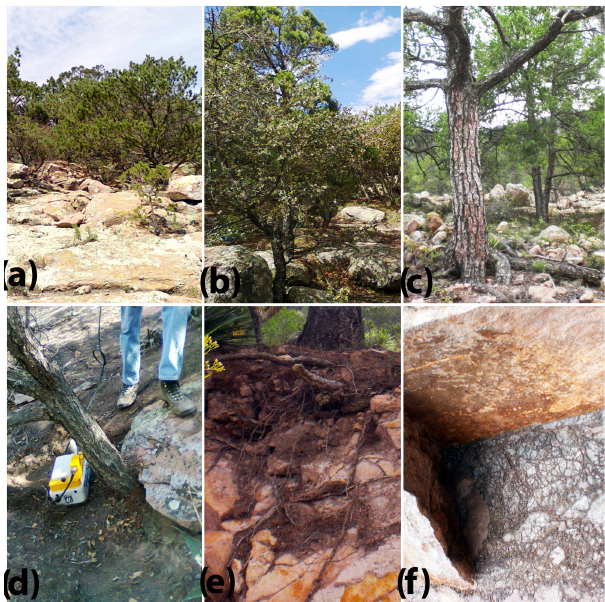
Figure 1. Site characteristics: (a) rhyolitic weathered bedrock in Pinus cembroides stands, (b) exfoliated rock in a pine–oak stand, (c) exposed coarse roots of 14cm diameter in shallow rocky soils, (d) pine anchored under exfoliated rock, (e) high root density at the soil–bedrock interface and (f) fine roots colonizing a weathered bedrock